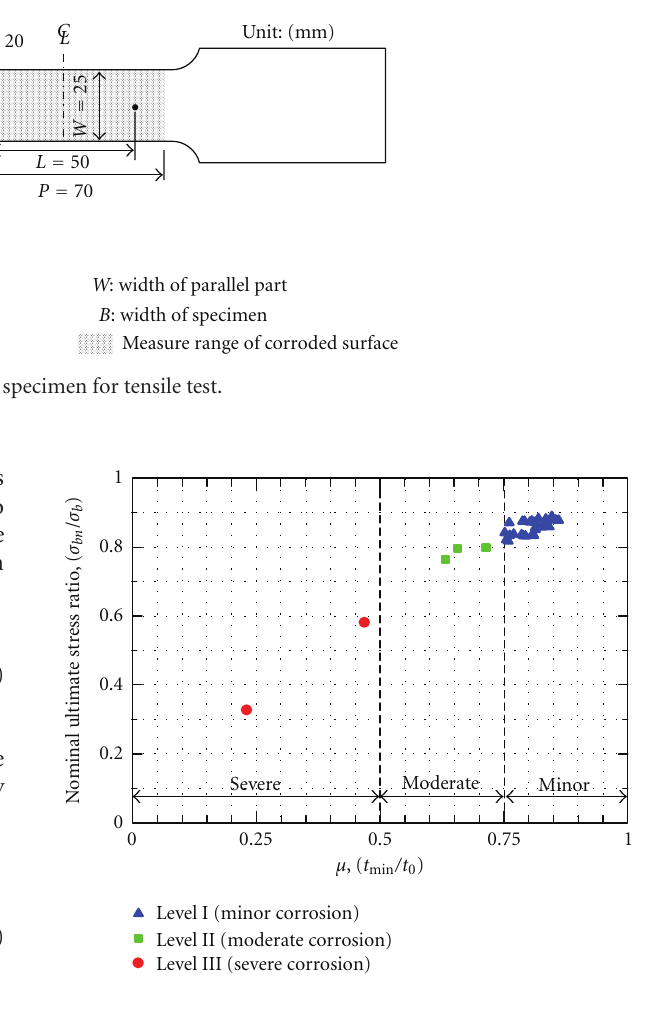
Figure 2: Relationship of ultimate stress ratio and minimum thick- ness ratio ( μ